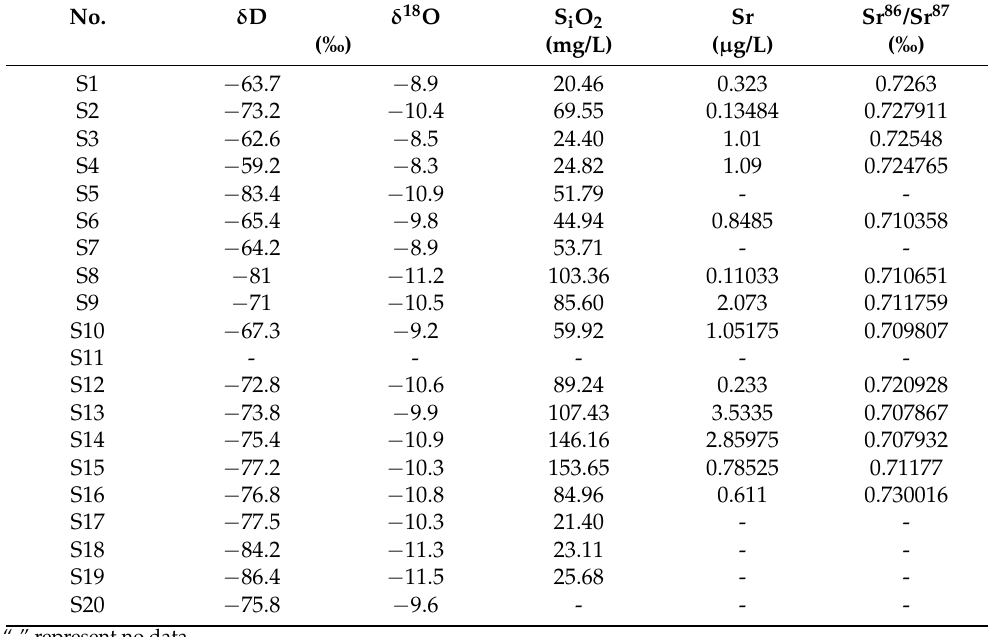
Figure 2. Time trend (dates indicated as yyyy) of the absolute values (in mg/L) and of the z scores of the variables Na + , K + , Ca 2+ , Mg 2+ , F − , Cl − , NO 3− , CO 32− , SO 42− , and HCO 3- from 2015–2019.